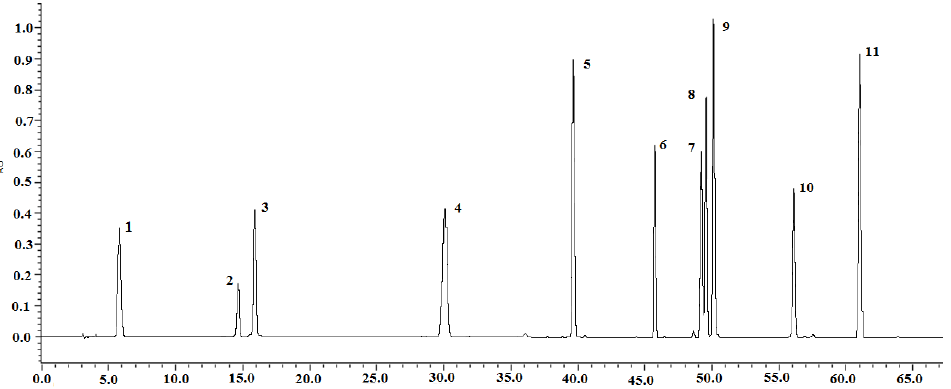
Figure 1. HPLC-DAD chromatograms recorded at 269 nm of the mixed reference compounds: Gallic acid ( 1 ), mangiferin ( 2 ), caffeic acid ( 3 ), tectoridin ( 4 ), germanism B ( 5 ), irisolidone- D -glucoside ( 6 ), iristectorigenin B ( 7 ), nigricin ( 8 ), irigenin ( 9 ), 5,6-dihydroxy-7,8,3′,5′-tetramethoxyisoflavone ( 10 ), and irisolidone ( 11 ).